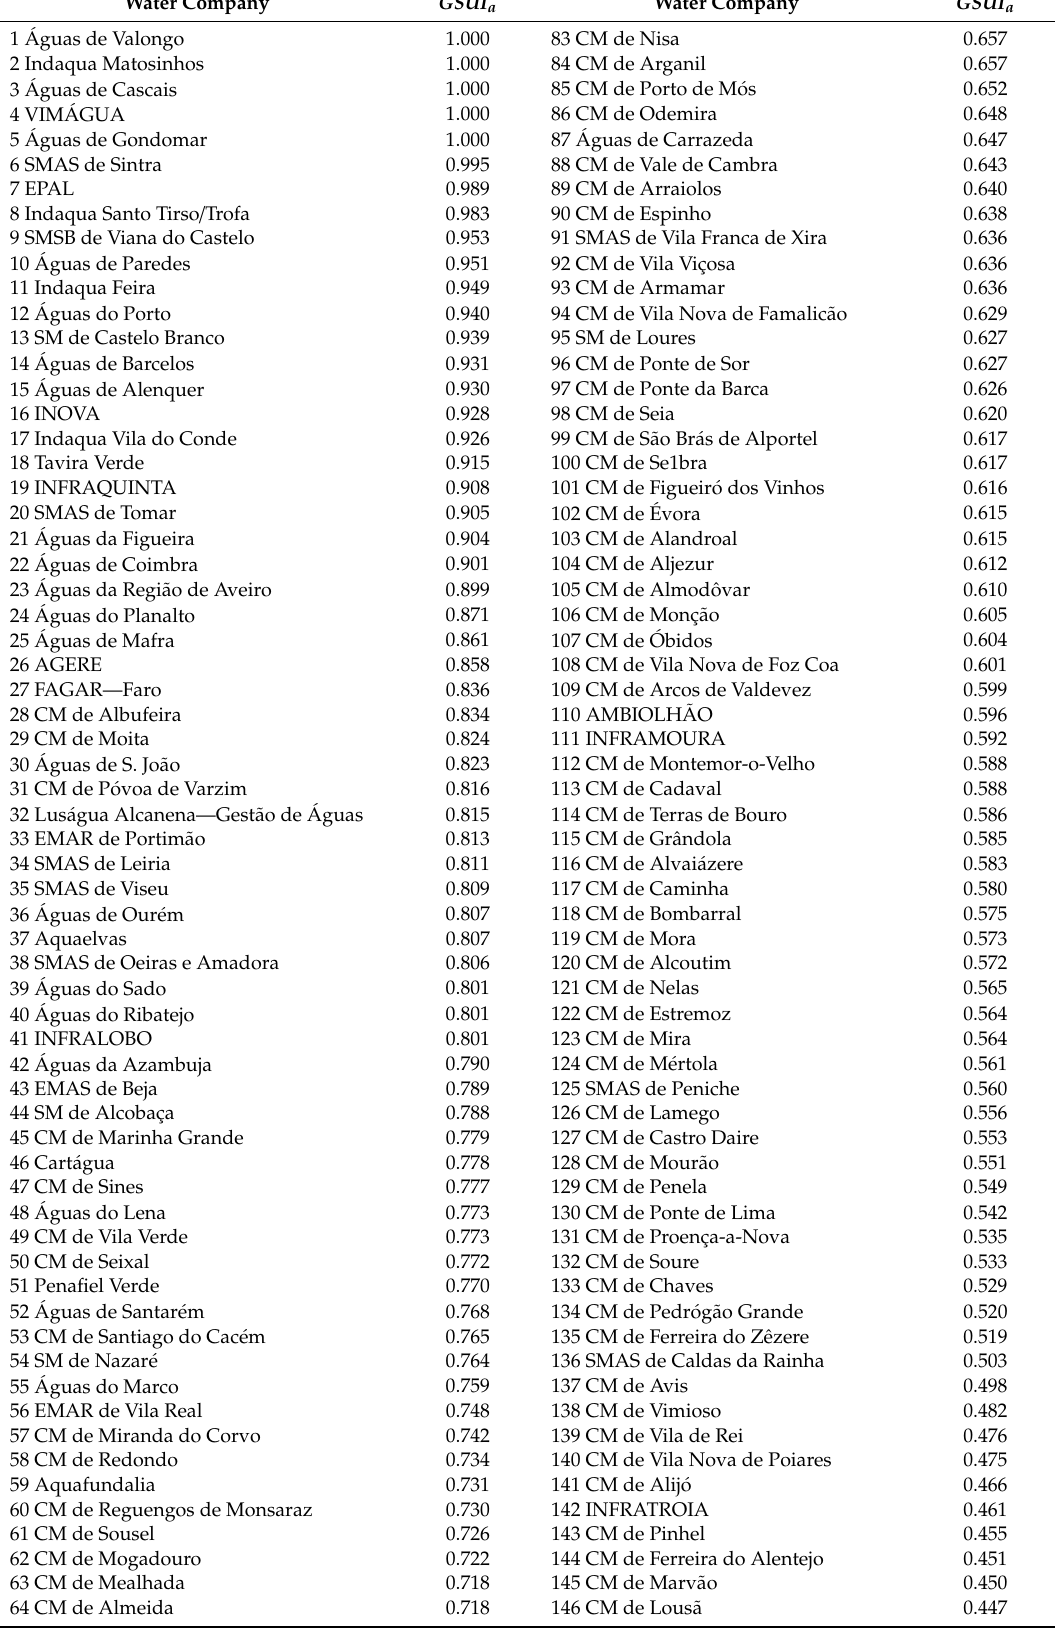
Table 5. Results for 163 water companies for global